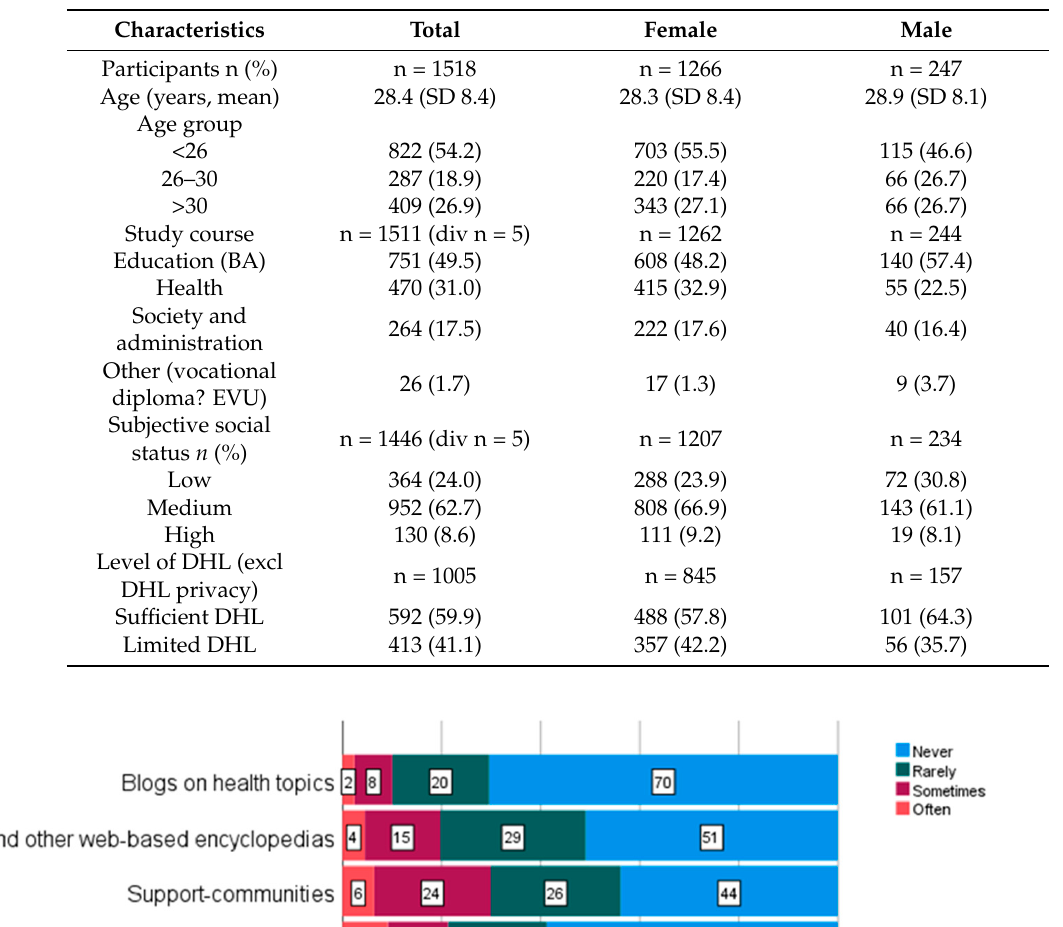
Table 2. Characteristics of participants (n = 1518).